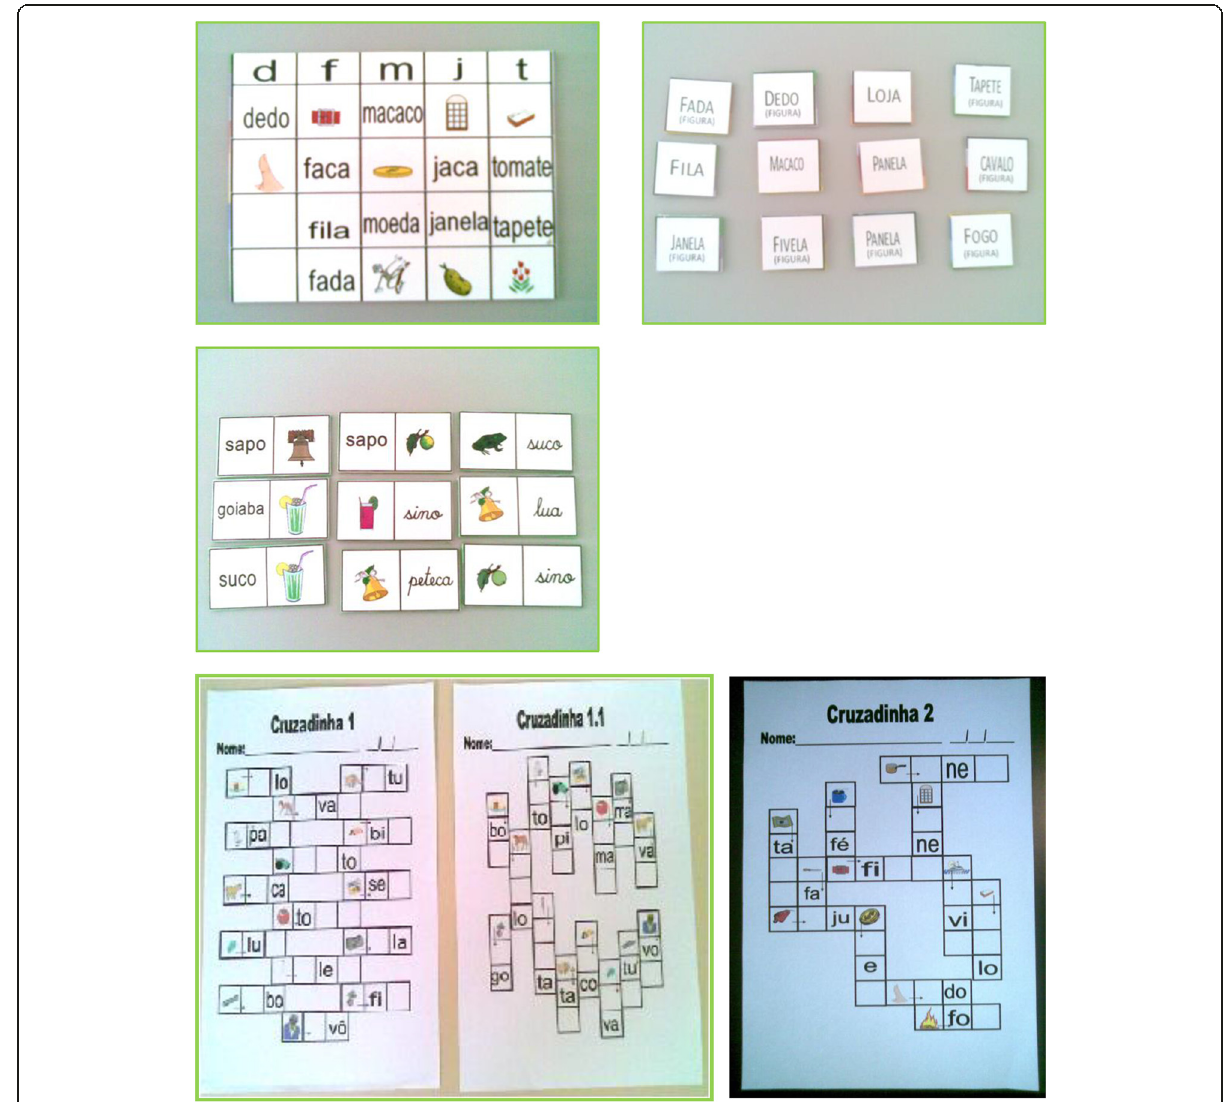
Fig. 1 Examples of each one of the games (bingo, domino,